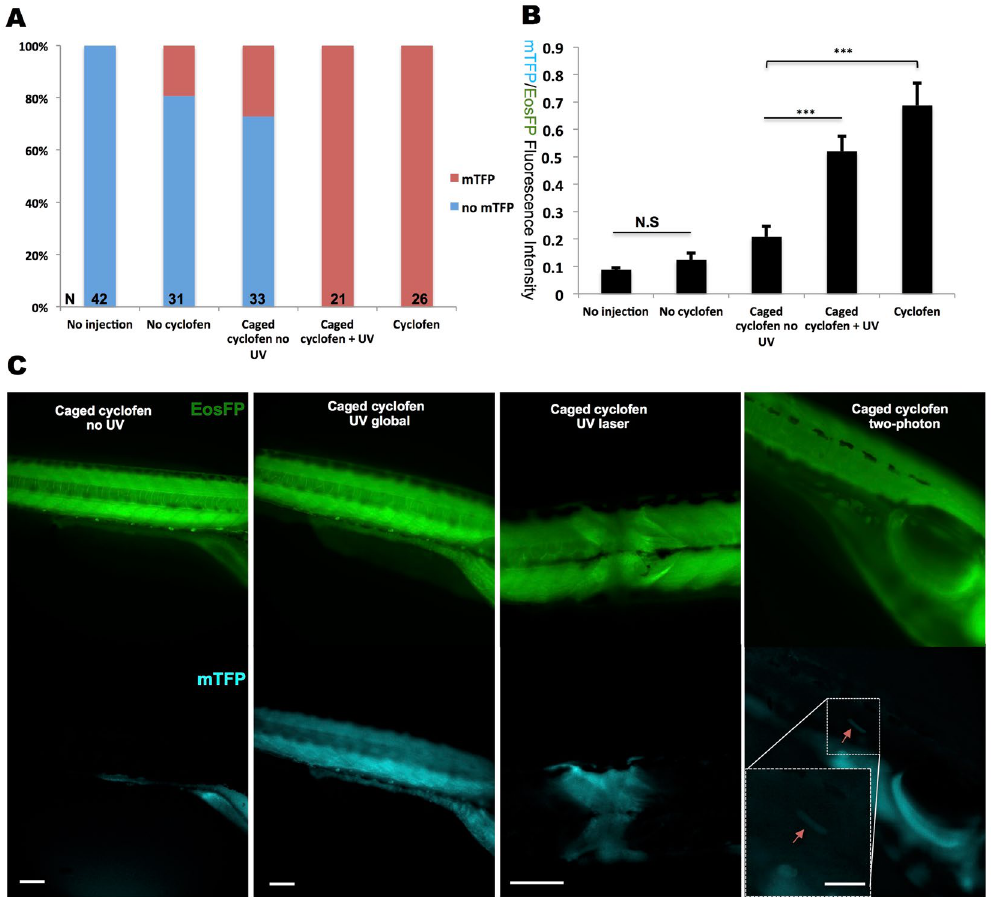
Figure 6. Constitutive photo-activation of kRASG12V expression in localized tissue and single cells. To induce constitutive activation of kRASG12V , Cre-ERT2 mRNA was injected into Tg(ubi:loxP-Eos-stop-loxP-kRASG12V- T2A-mTFP) embryos at the one-cell stage. ( A ) Despite some minor light independent activation of Cre, mTFP expression could be fully induced by both cyclofen and caged cyclofen photo-activation. ( B ) Quantification of kRASG12V activation signal via the ratio of the fluorescence of the co-expressed mTFP protein and the (partially) floxed Eos protein. (C) UV (lamp or laser) and two-photon activation were performed at 10hpf to achieve global (with the UV lamp), local (with the UV laser) and single cell (with 2-photon laser) activation. Fish were imaged at 2dpf. Scale bar: 200 μ m. Data are presented as mean ± SEM. *** p < 0.001; N.S, not